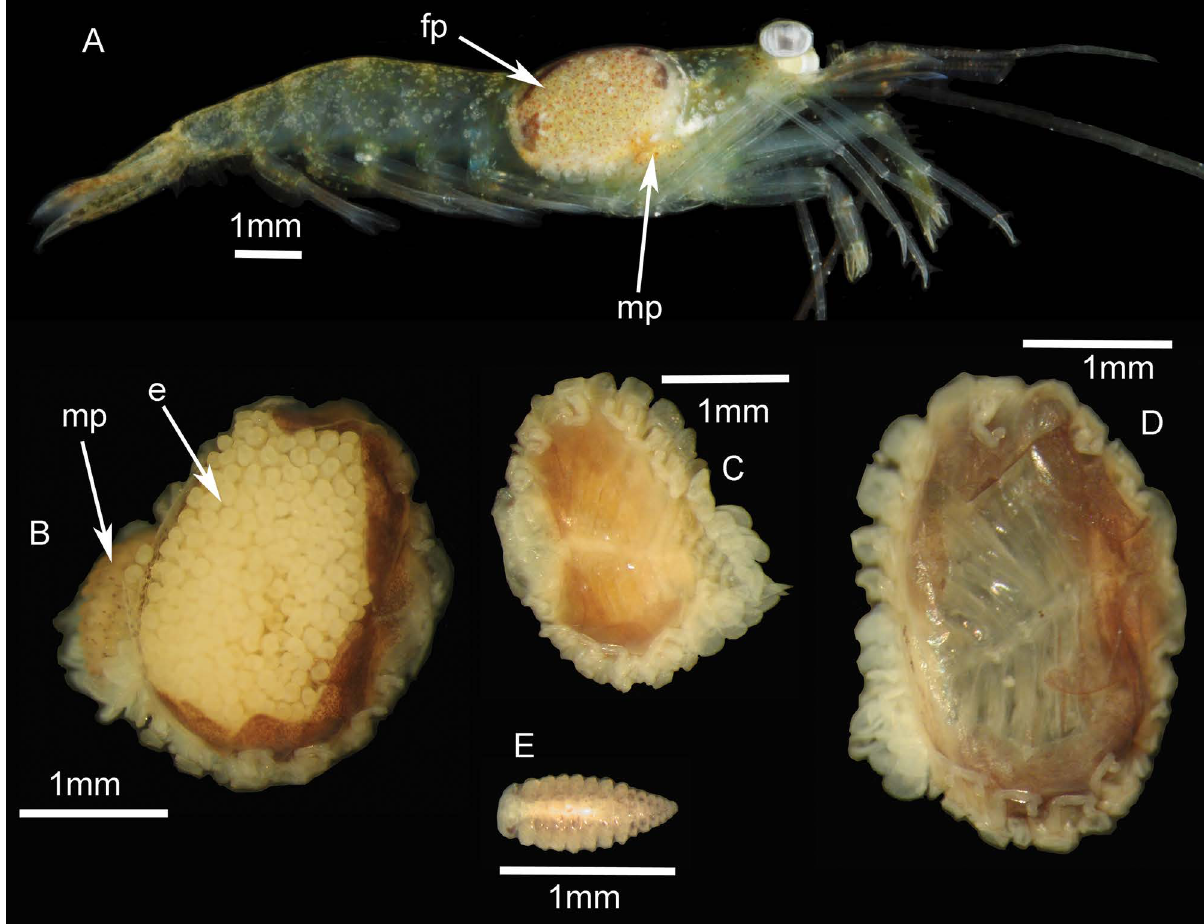
Figure 1. Urobopyrus processae . (A) U. processae female (fp, cephalic end) and male (mp) infesting a male shrimp Ambidexter symmetricus. (B) Female U. processae incubating embryos (e); (mp) male bopyrid. (C) Juvenile female U. processae (cephalon is to the left). (D) Adult female U. processae with empty marsupium (cephalon is to the right). (E) Adult male U.